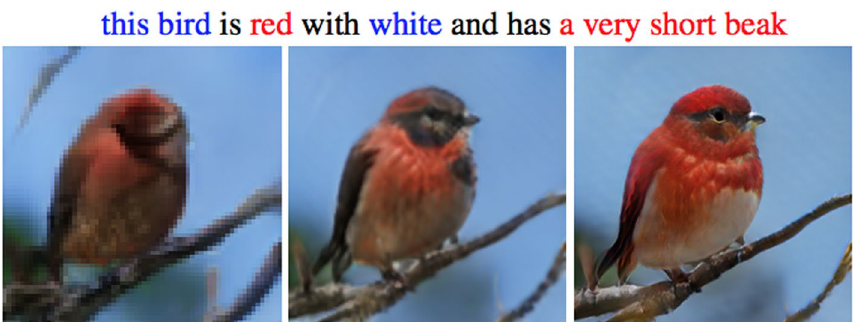
Fig. 20 An example of text‑to‑image translation